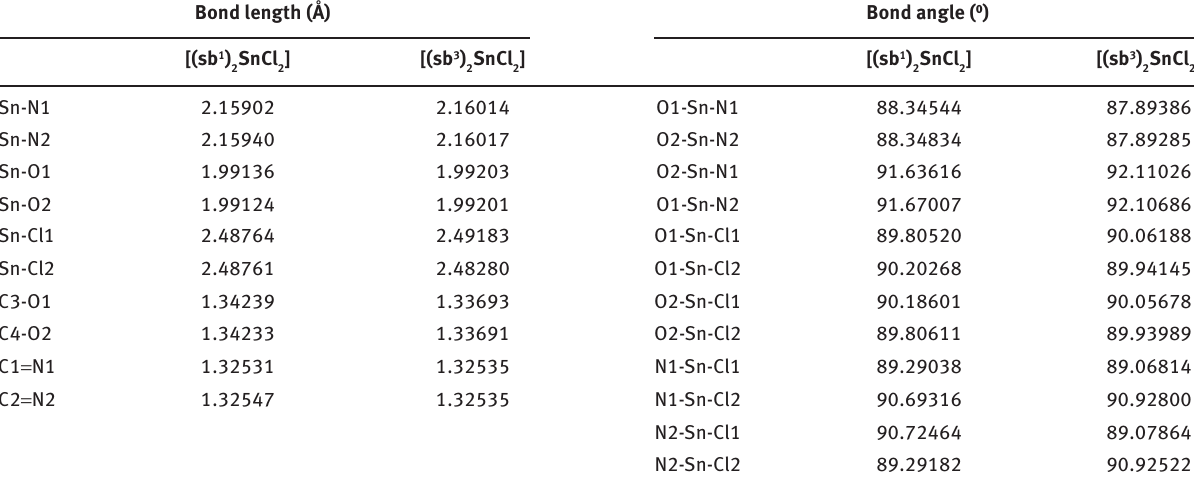
SnCl ], 1 and [(sb 3 ) SnCl ], 3 at B3LYP/LanL2DZ level of 2 2 2 2